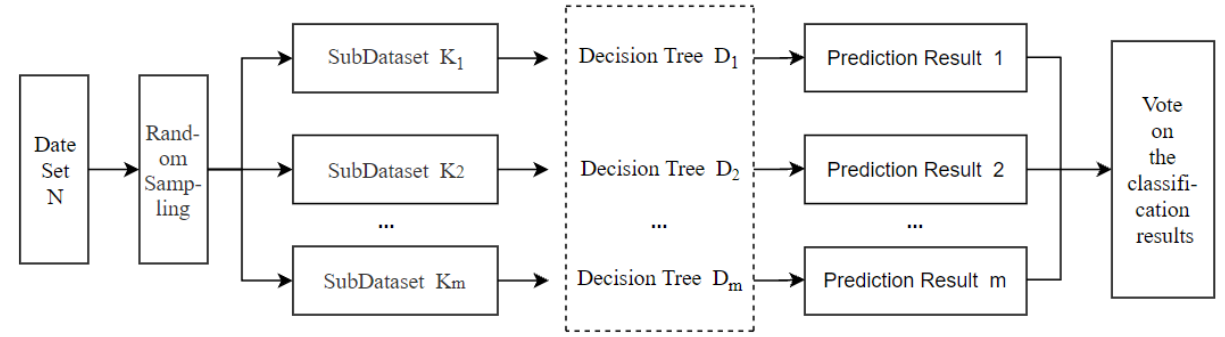
Figure 2. The principle of the random forest algorithm.